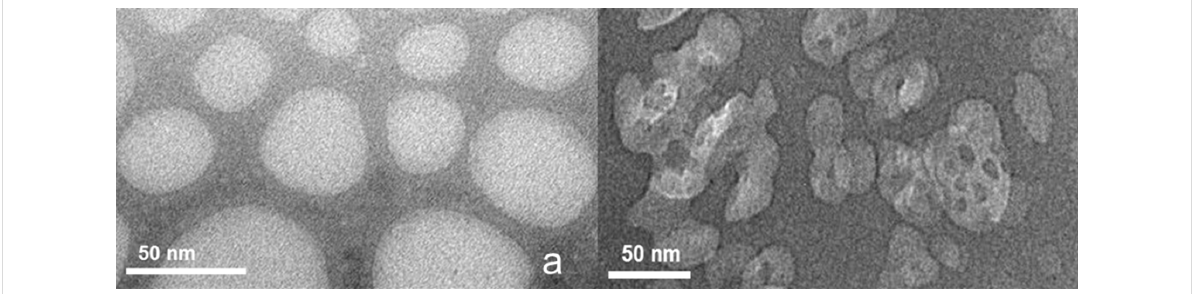
Figure 4: TEM images of: a) CDNSEDTA (1:4) and b) CDNSEDTA (1:8).